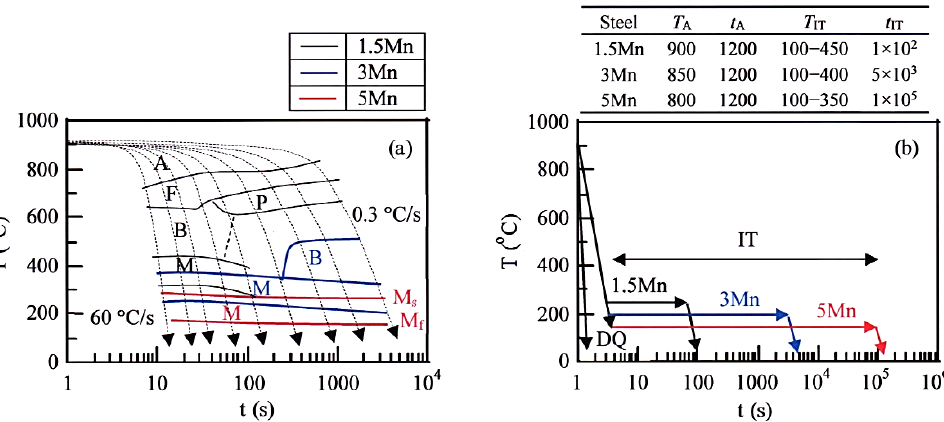
Figure 1. ( a ) CCT diagrams and ( b ) heat treatment diagram of the 1.5Mn, 3Mn, and 5Mn steels. “A”, “F”, “P”, “B”, and “M” in ( a ) are austenite, ferrite, pearlite, bainite, and martensite, respectively. “DQ” and “IT” represent direct quenching to room temperature and isothermal transformation, respectively. T A ( ◦ C): austenitizing temperature, t A (s): austenitizing time, T IT ( C): IT temperature, t IT (s): IT time.